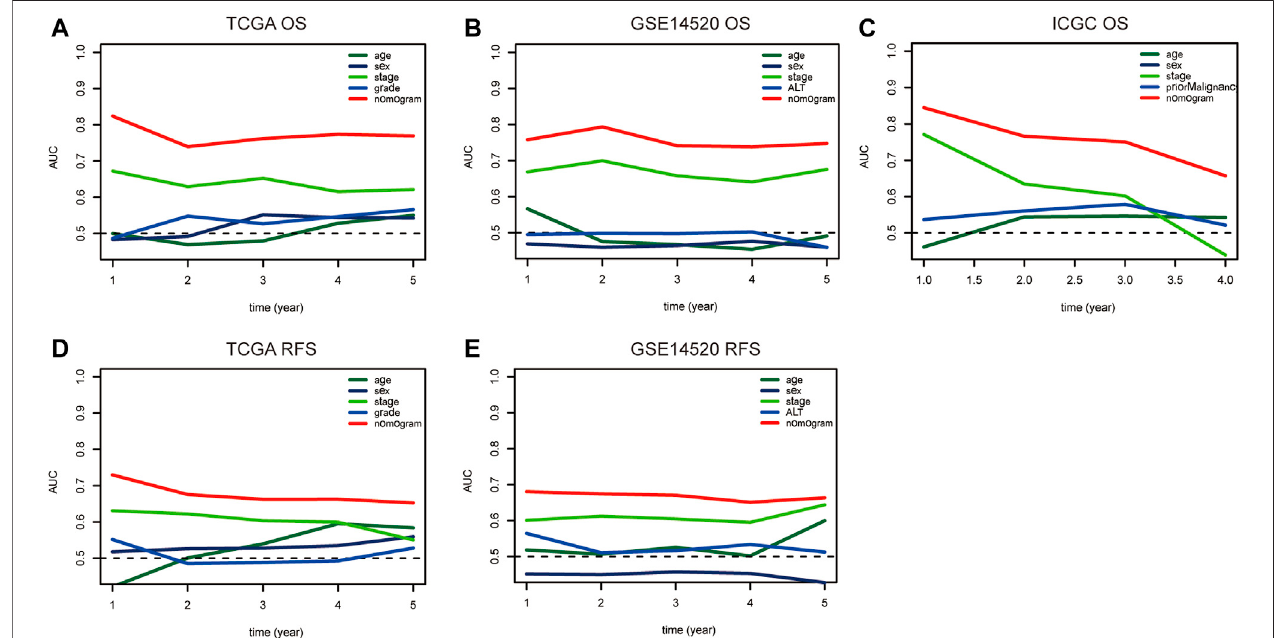
FIGURE8| Thetime-dependentROCcurveisusedtoevaluatethepredictivevaluebetweenthenomogrammodelandclinicopathologicalcharacteristicsinTCGA (A – D) , GSE14520 (B – E) , and ICGC (C) dataset. Notes: ROC: Receiver Operating Characteristic; TCGA: The Cancer Genome Atlas Program; ICGC: International Cancer Genome